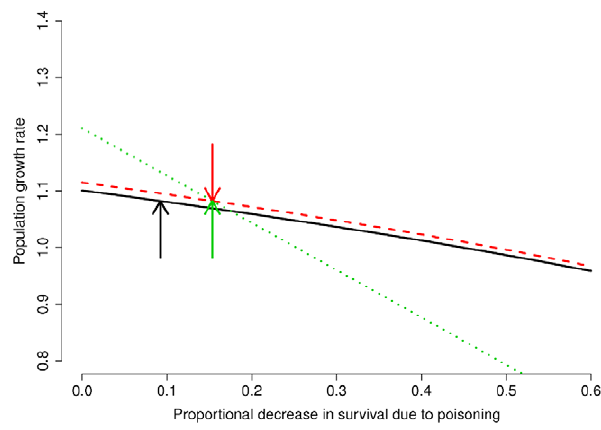
Figure 2. Changes of population growth rate in relation to changes in the proportional decrease of age-specific survival probability. The black solid line represents the relationship with proportional reduction in juvenile survival ( d juv ), the red dashed line refers to d 1 y , and the green dotted line refers to d 2 my . Current age- specific values of d are indicated by the arrows with the same colour of the curve to which they refer.